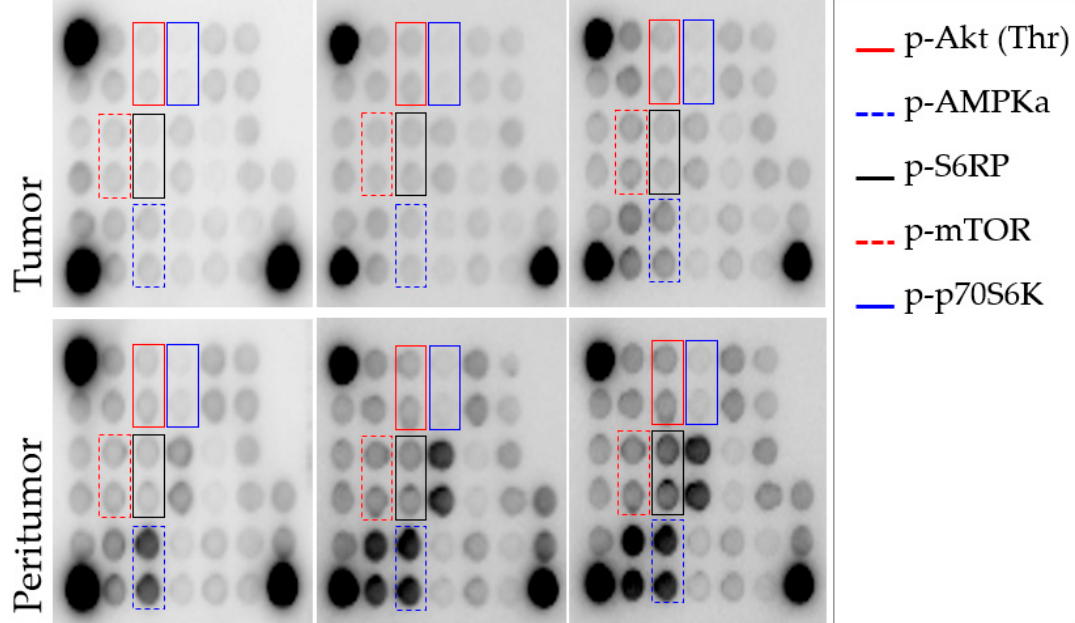
Figure 5. Representative panels showing the output from the PathScan intracellular signalling array in 6 tissue samples: 3 tumoral samples ( upper panel ) and 3 peritumoral samples ( lower panel ). The whole array included immobilized antibodies against 18 proteins when phosphorylated or cleaved (by duplicate), which are related to the mTOR-signalling pathway. Each protein is represented by a pair of spots. Those proteins with a statistically different intensity between tumoral and peritumoral samples are marked with colour rectangles in both arrays. Abbreviations: p-Akt, phospho protein kinase B or PKB; p-AMPKa, phospho protein kinase AMP-activated catalytic subunit alpha 1 or PRKAA1; p-S6RP, phospho S6 Ribosomal Protein; p-mTOR, phospho mechanistic target of rapamycin; p-p70S6K, phospho ribosomal protein S6 kinase beta-1 or S6K1.